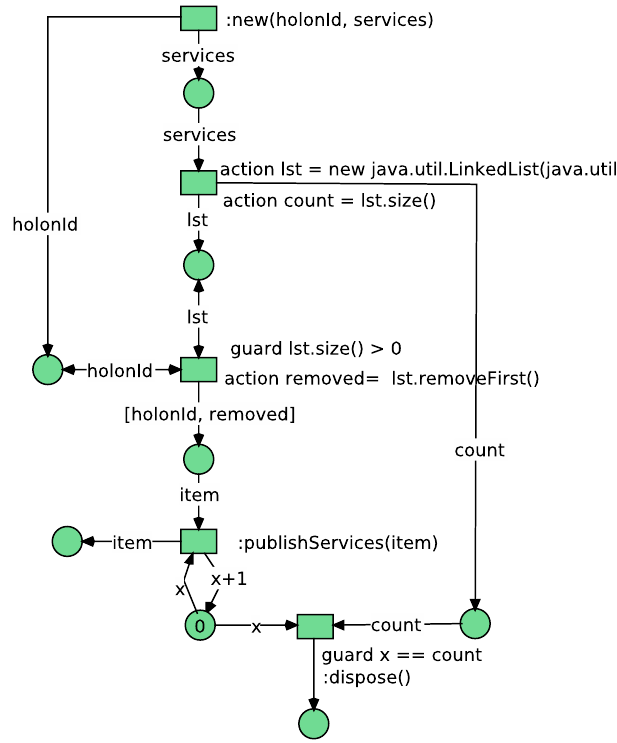
Figure 10. Service logging auxiliary